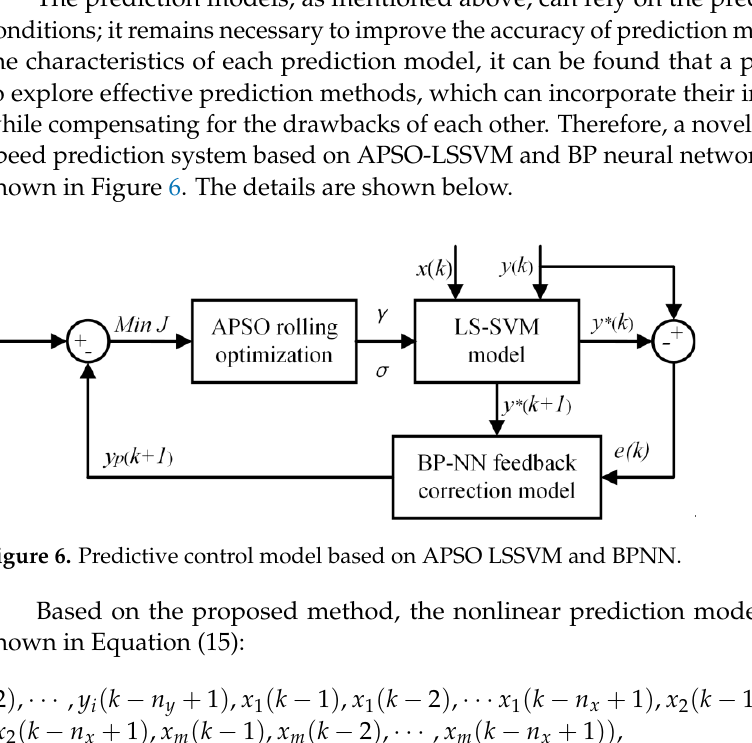
Figure 5. Structure of BP neural network. ( a ) Learning neural network; ( b ) prediction neural network. Table 4. BP NN model parameters.